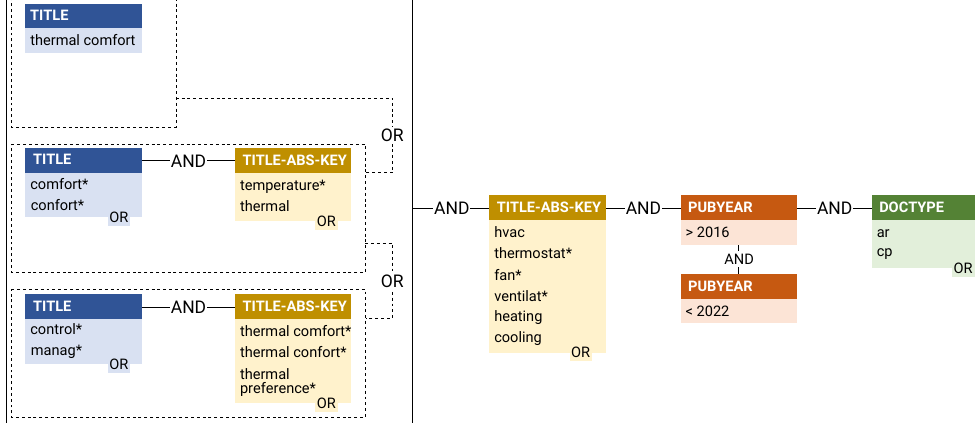
Figure 1. Graphical visualization of query string. Keywords in filled boxes were searched with